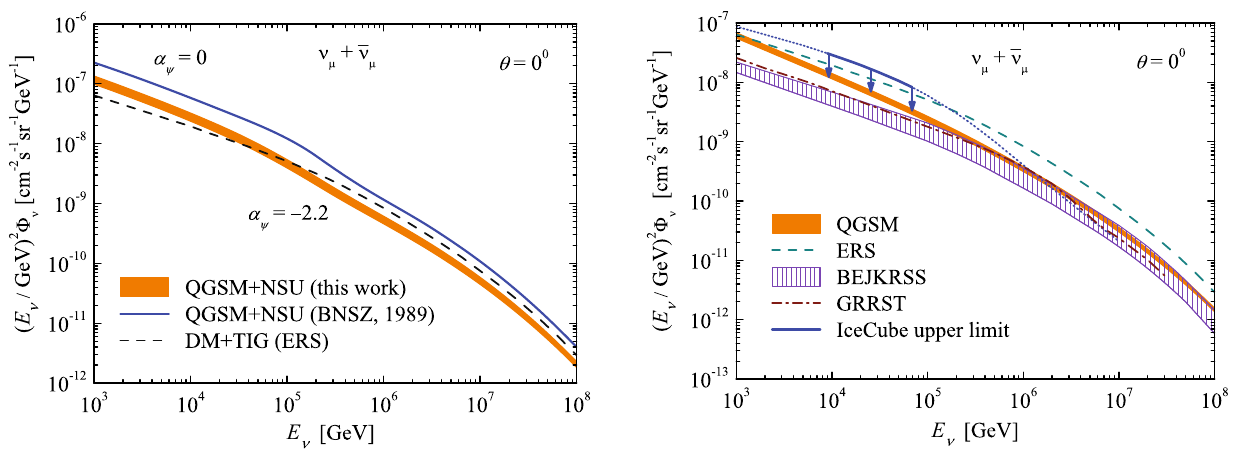
Fig. 15 Vertical flux of prompt atmospheric neutrinos calculated with QGSM for the NSU cosmic-ray spectrum. Shaded band: this work with α ψ ( 0 ) = − 2 . 2. The band width corresponds to the variation of a 2 (lower bound) to 30 (upper bound). The solid line presents the result from Refs. [15,21] obtained with α ψ ( 0 ) = 0. Dash line plots the dipole